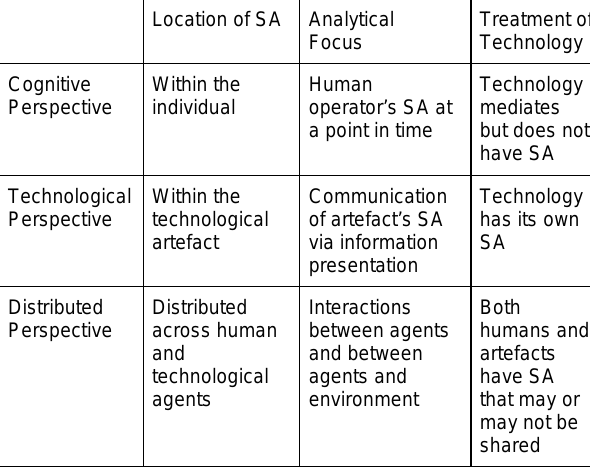
Table 1 Theoretical perspectives of